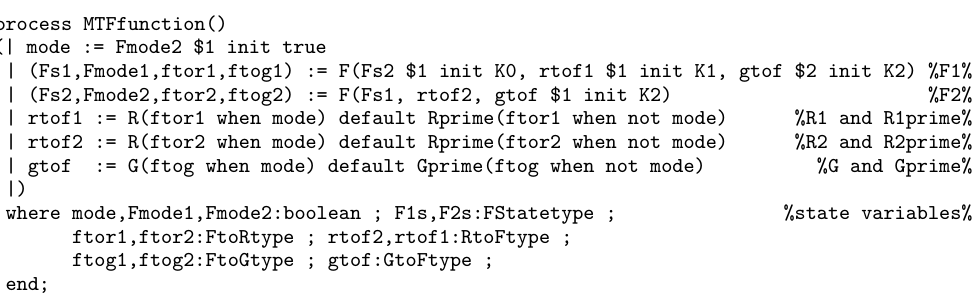
Figure 4 Synchronous program corresponding to the task system of Figure